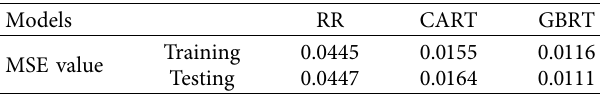
Table 2: Comparison of the different models based on different datasets. Models